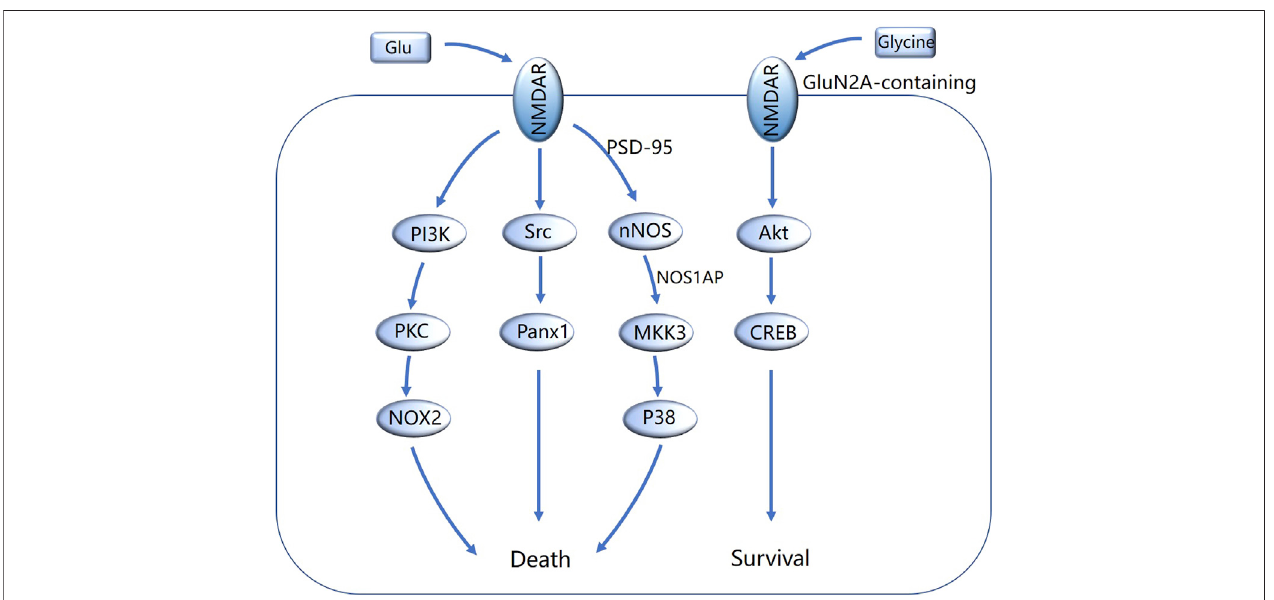
FIGURE1| OverviewofmetabotropicNMDAreceptor(NMDAR)signalingpathwaysinvolvedincerebralischemia.ExcessiveglutamatebindstotheGluN2subunit ofNMDAreceptorsandinitiatesseveralpro-deathsignalingpathways,suchasPI3K-PKC-NOX2,Src-PanX1andnNOS-MKK3-p38.GlycinebindstotheGluN1subunit of GluN2A-containing NMDA receptors, activates Akt-CREB signaling pathway and promotes the survival of